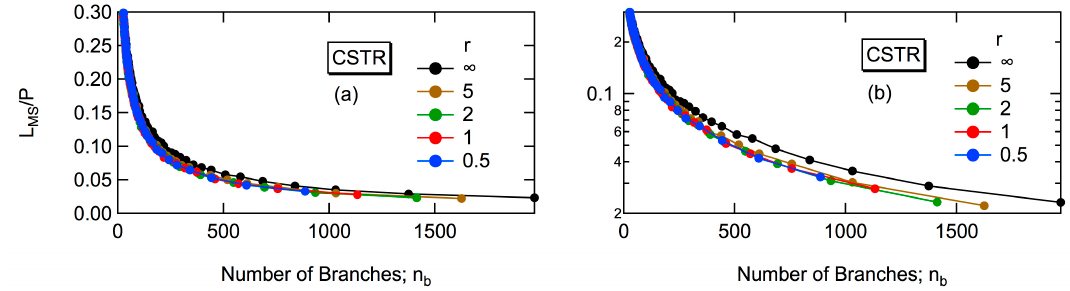
Figure 24. Relationship between L MS / P and n b for a CSTR with various reactivity ratios. The plotted values are at ξ UL for each r . ( a ) Normal scale plot, and ( b ) logarithmic scale plot.